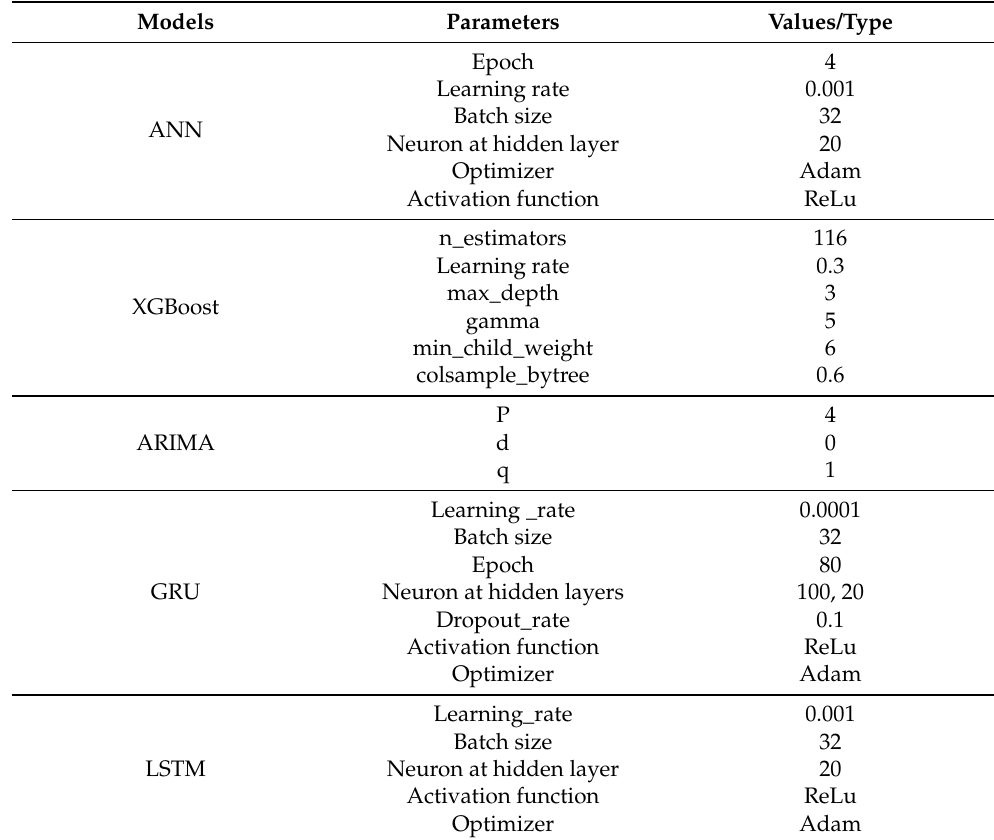
Table 2. Hyperparameters for the baseline